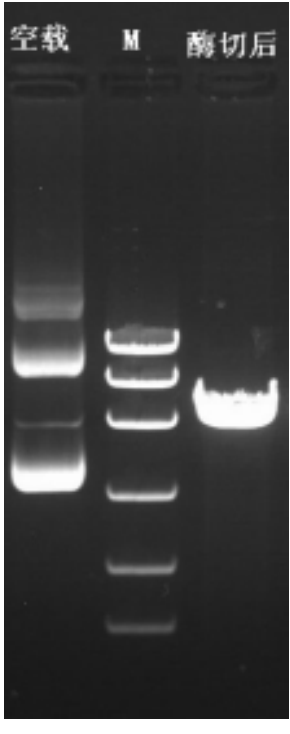
Figure 5. Identification of the pSGU6/GFP/Neo sh-RNA vector. Note: left of the marker is an empty PCR band of 413bp, and on the right is a positive PCR fragment of the 429bp